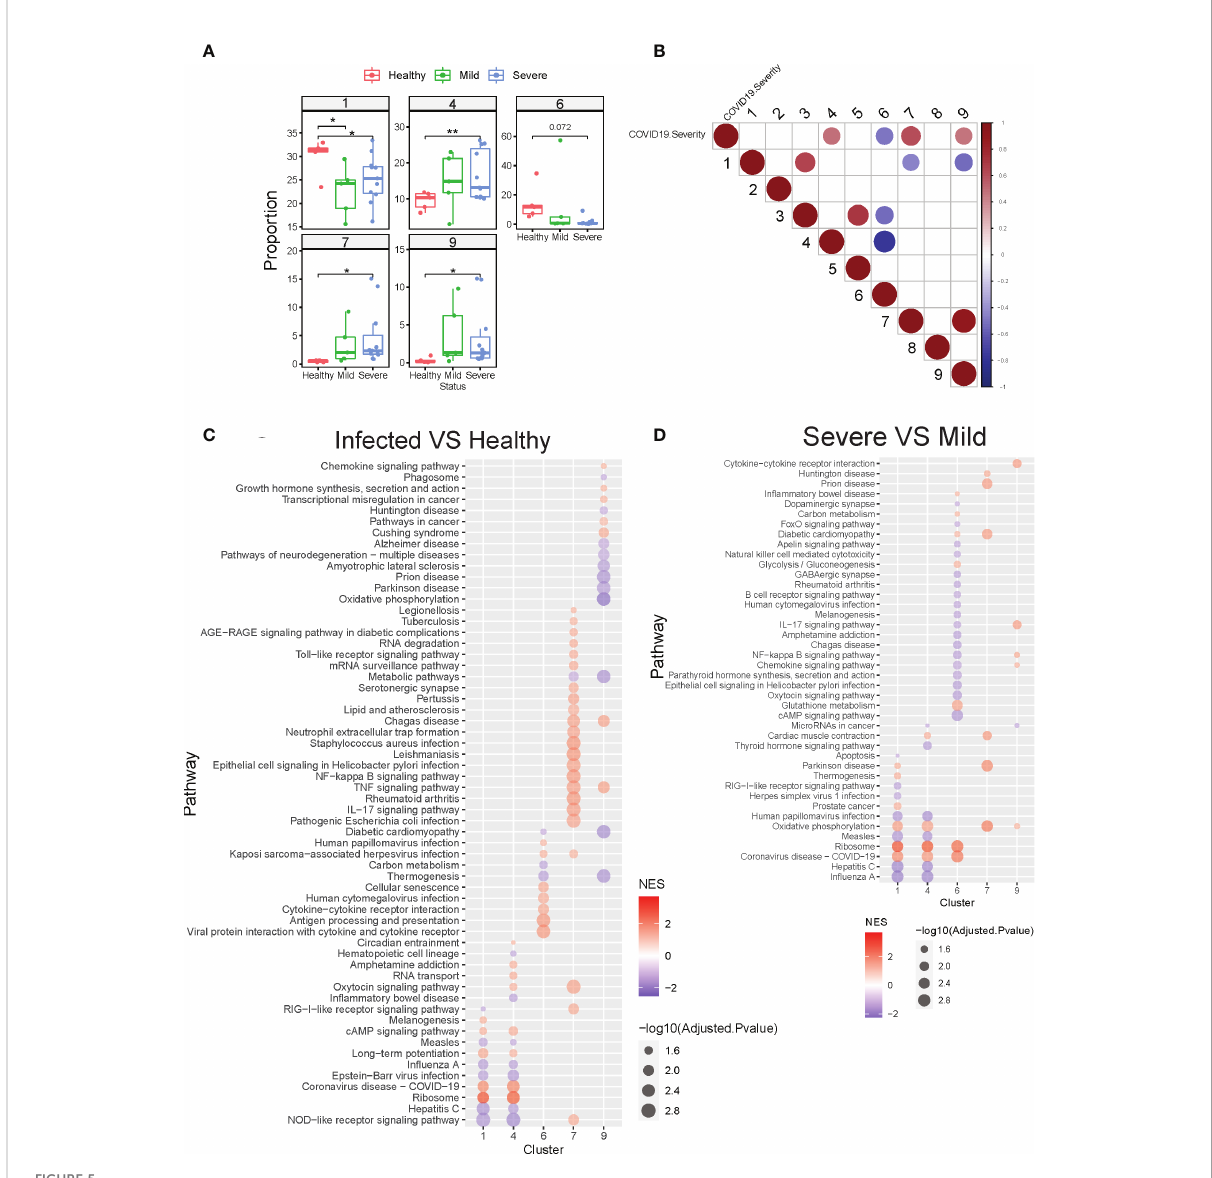
FIGURE 5 COVID-19 resulted in alterations of neutrophil subset compositions and their transcription pro fi les. (A) Neutrophil clusters that differed in proportions (% of neutrophils) between healthy controls and hospitalized patients with mild or severe COVID19. (B) Neutrophil clusters that signi fi cantly (adjusted P-value <0.05) associated with the severity of COVID19. Spearman ’ s ’ correlations were used to determine the association between cluster proportion and the severity of COVID19 (healthy 1, mild 2, severe 3, decreased 4). Red: positive correlation; Blue: negative correlation. Depth of color increase with the absolute value of the association. Only signi fi cant associations (adjusted P-value <0.05) are shown in this graph. (C) GSEA analysis of signi fi cantly different KEGG pathway gene sets in selected neutrophil clusters from COVID19 patients compared with that from healthy controls. (D) GSEA analysis of signi fi cantly different KEGG gene sets in selected neutrophil clusters from severe COVID19 patients compared with that from mild COVID19 patients. *p < 0.05, **p < 0.01. NES, Normalized enrichment